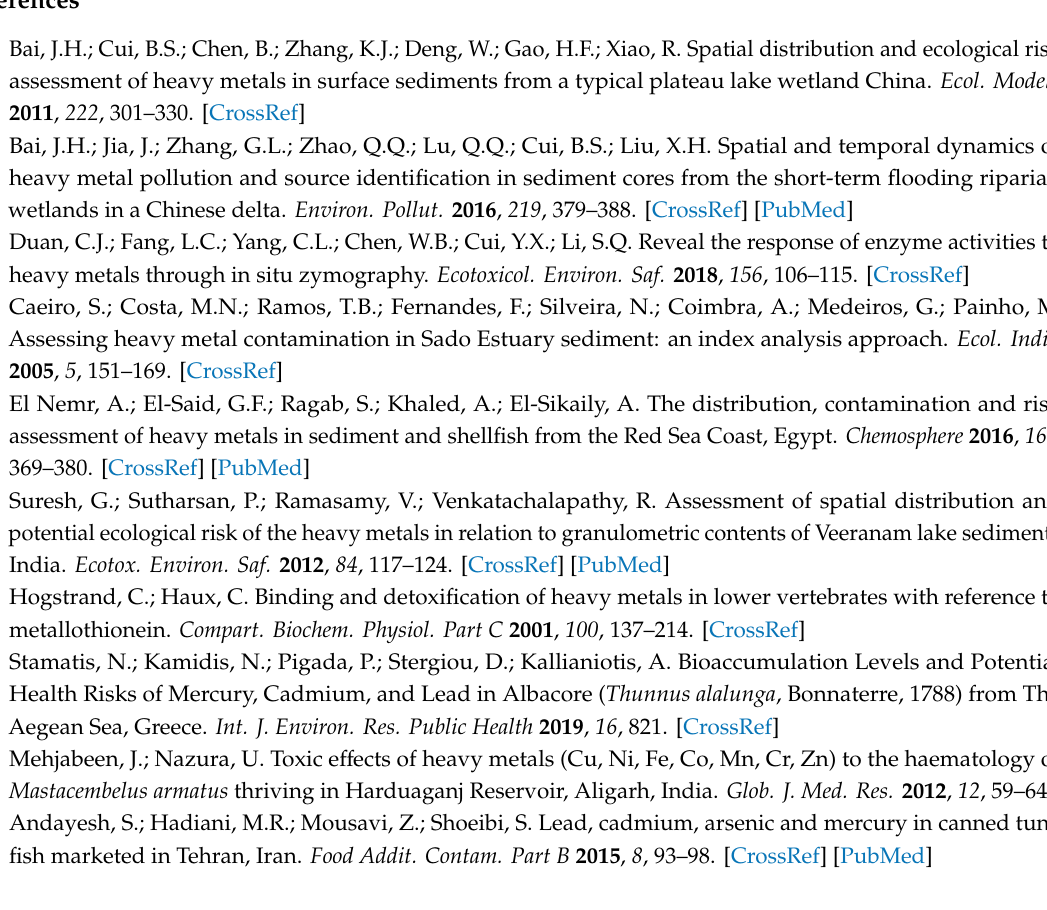
Table S1: Geoaccumulation index (I geo ) values of heavy metals of sediment samples in the three investigated gulfs, North Aegean Sea, Greece, Table S2: Potential risk factor (PRF i ) and potential ecological risk index (PERI) of heavy metals in sediment samples of three investigated gulfs, North Aegean Sea,